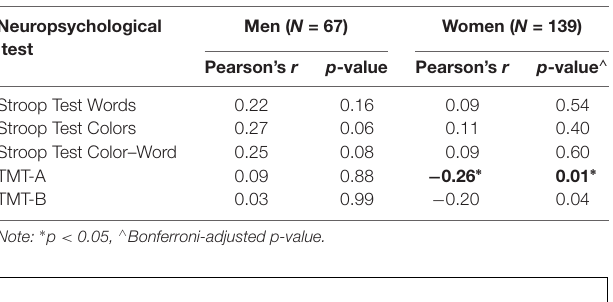
TABLE 3 | Correlations between the total METs of physical activity and the neuropsychological tests stratified by sex.